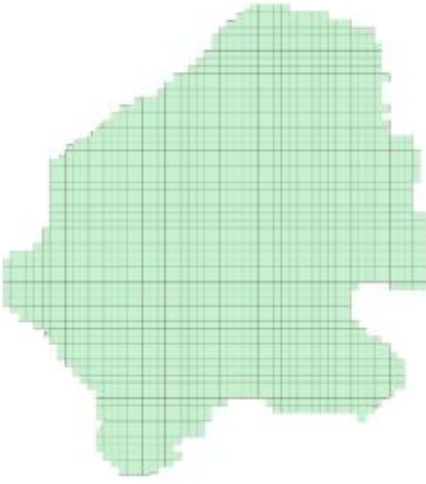
Figure 8. The Gilmer County LiDAR dataset.